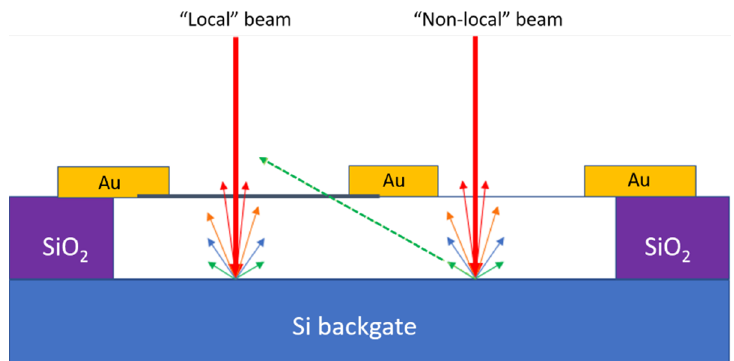
Figure 4. Schematic representation of the role of backscattered electrons on the electrical transport properties of suspended graphene devices. The measured graphene channel is depicted by the black line between the leftmost and the central Au electrodes. In “non-local” exposure (rightmost red beam), only the high-angle (with respect to the Si surface normal) and low cross-section backscattered electrons from the Si backgate manage to reach the graphene channel and mildly affect its resistivity. The dashed green arrow represents this situation. In contrast, in the “local” exposure situation (leftmost beam), low-angle and high cross section backscattered electrons impact the graphene channel, drastically affecting its electrical properties.